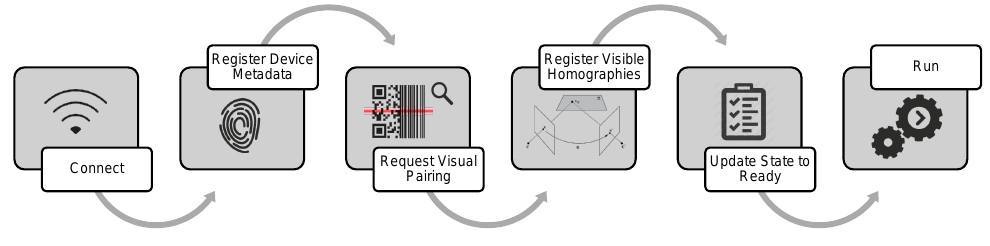
Figure 2. Process that establishes the ground rules for managing the flow of data between the two